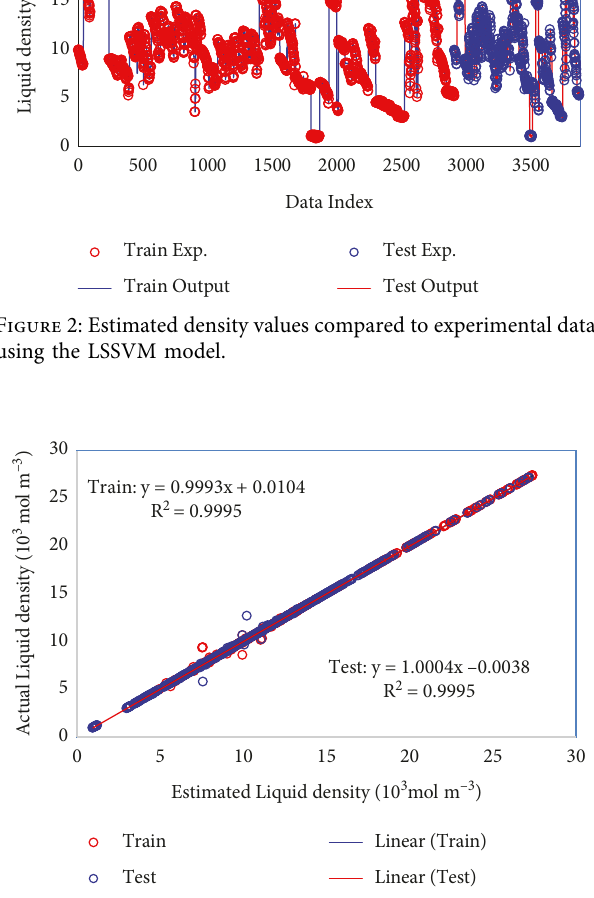
Figure 3: Regression diagram to estimate density using the LSSVM model.